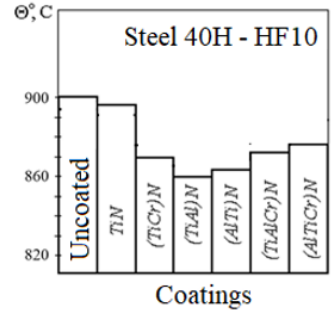
Fig. 3. Effect of coating type on temperature in the cutting zone during longitudinal turning